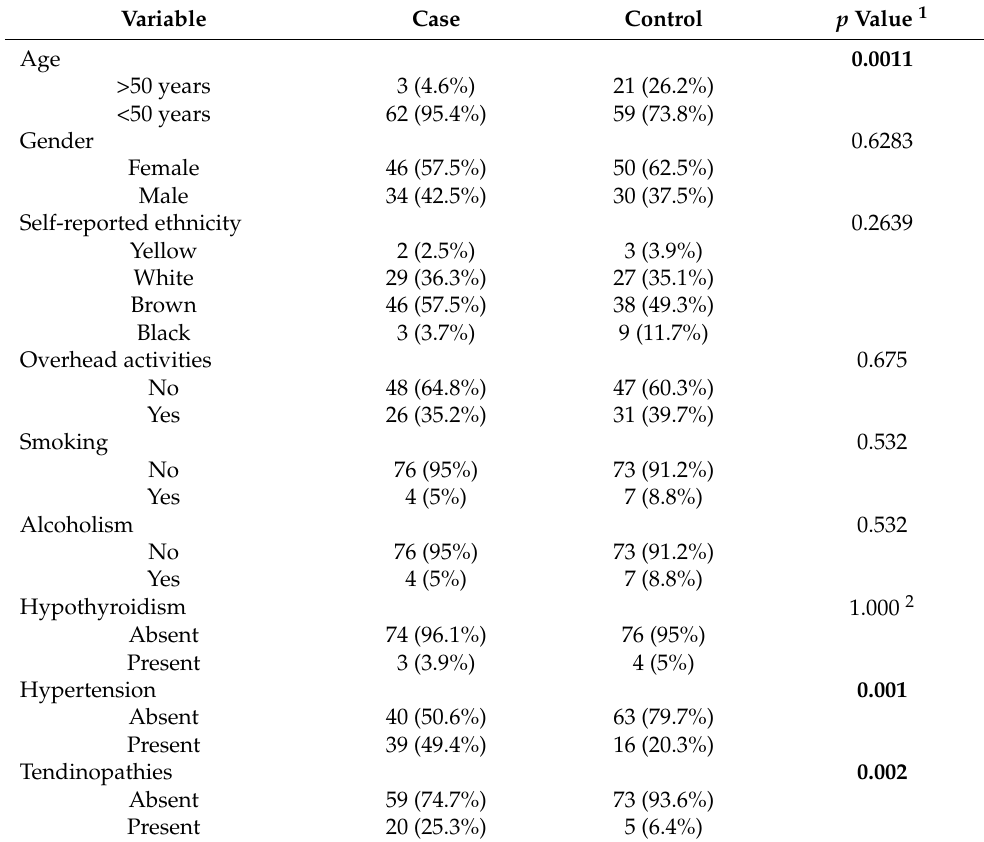
Table 1. Clinical–epidemiological variables of the case and control